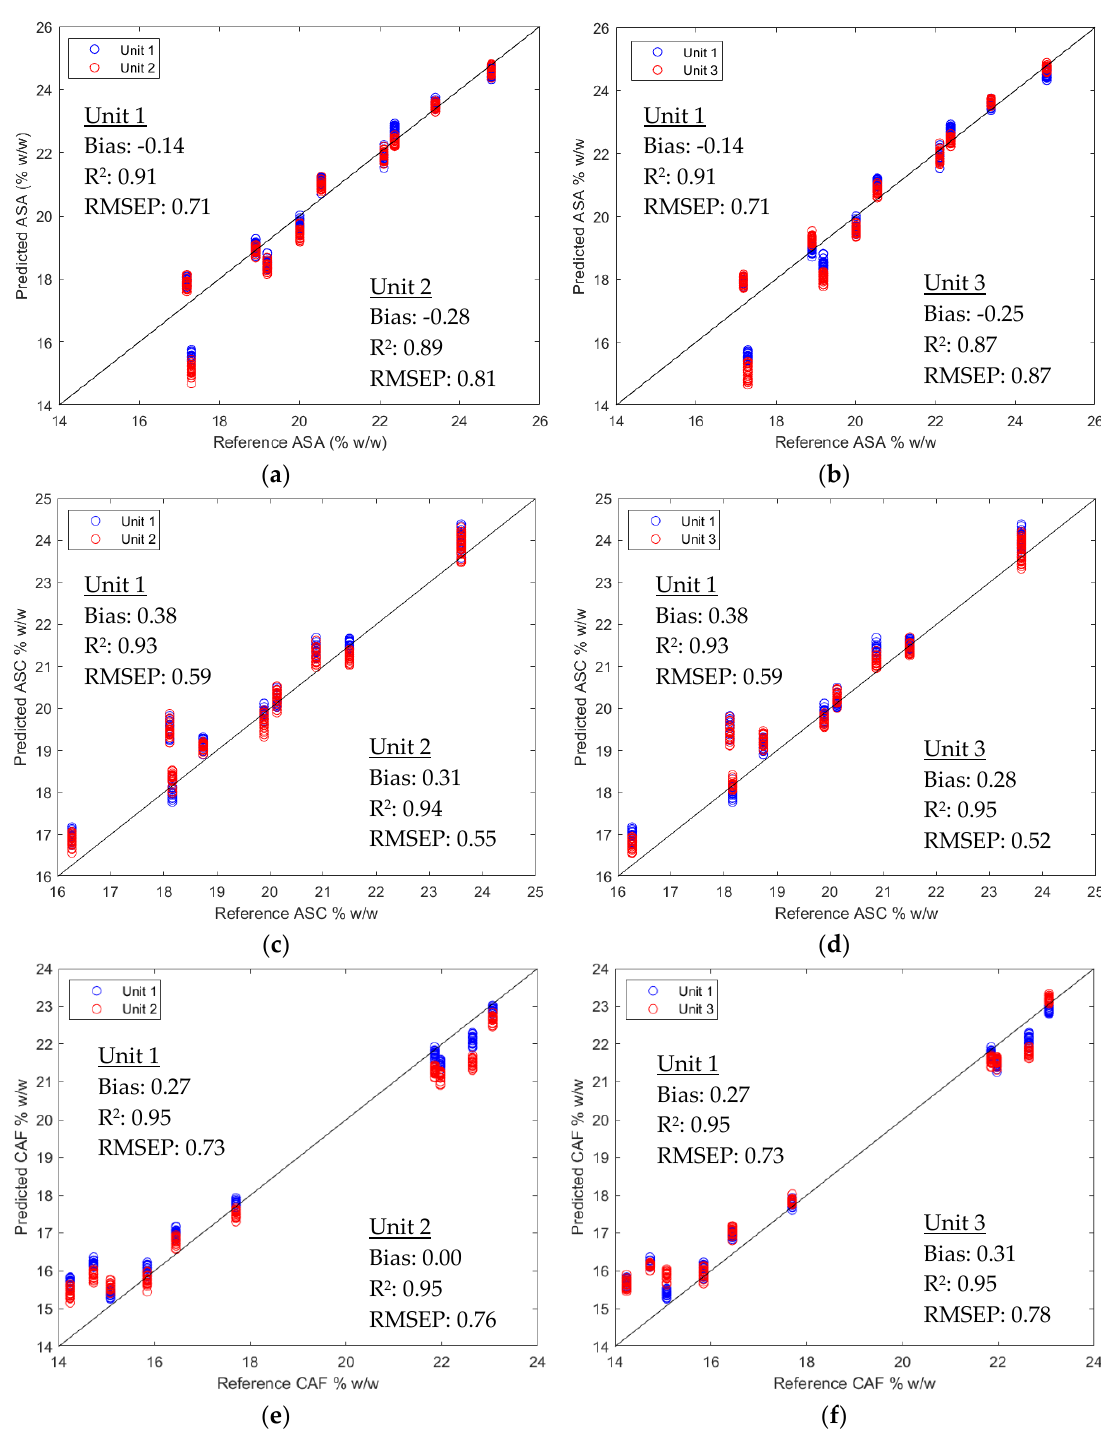
Figure 1. Predicted values versus reference values using models developed on Unit 1: (a) Validation sets by Unit 1 and Unit 2 for ASA prediction; (b) Validation sets by Unit 1 and Unit 3 for ASA prediction; (c) Validation sets by Unit 1 and Unit 2 for ASC prediction; (d) Validation sets by Unit 1 and Unit 3 for ASC prediction; (e) Validation sets by Unit 1 and Unit 2 for CAF prediction; (f) Validation sets by Unit 1 and Unit 3 for CAF prediction. The corresponding bias, R 2 for prediction, and root mean square error for prediction (RMSEP) are presented in each plot.